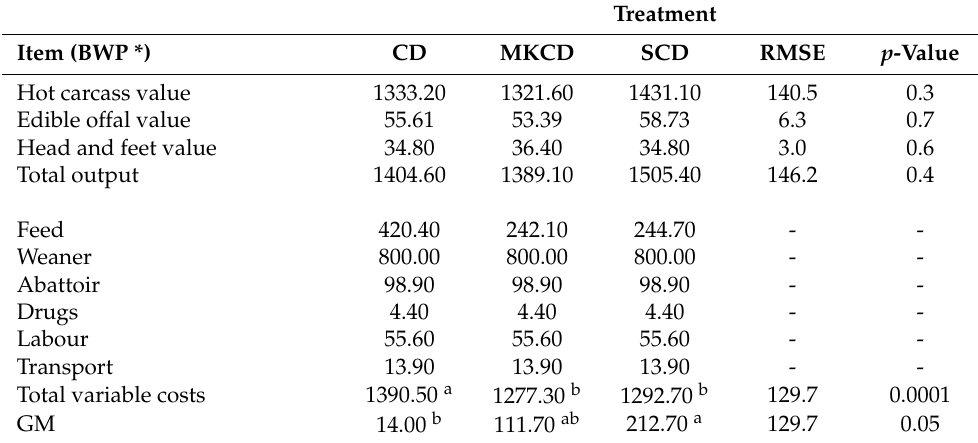
Table 10. Gross margin analysis (per lamb) of the three treatment